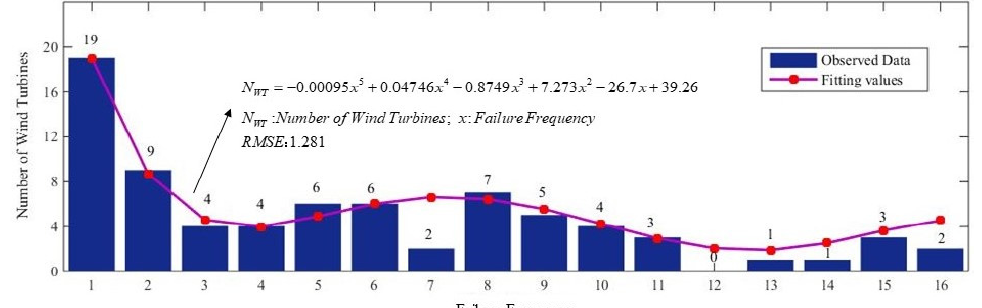
Figure 4. Failure frequency of wind turbines (RMSE: Root Mean Square Error).